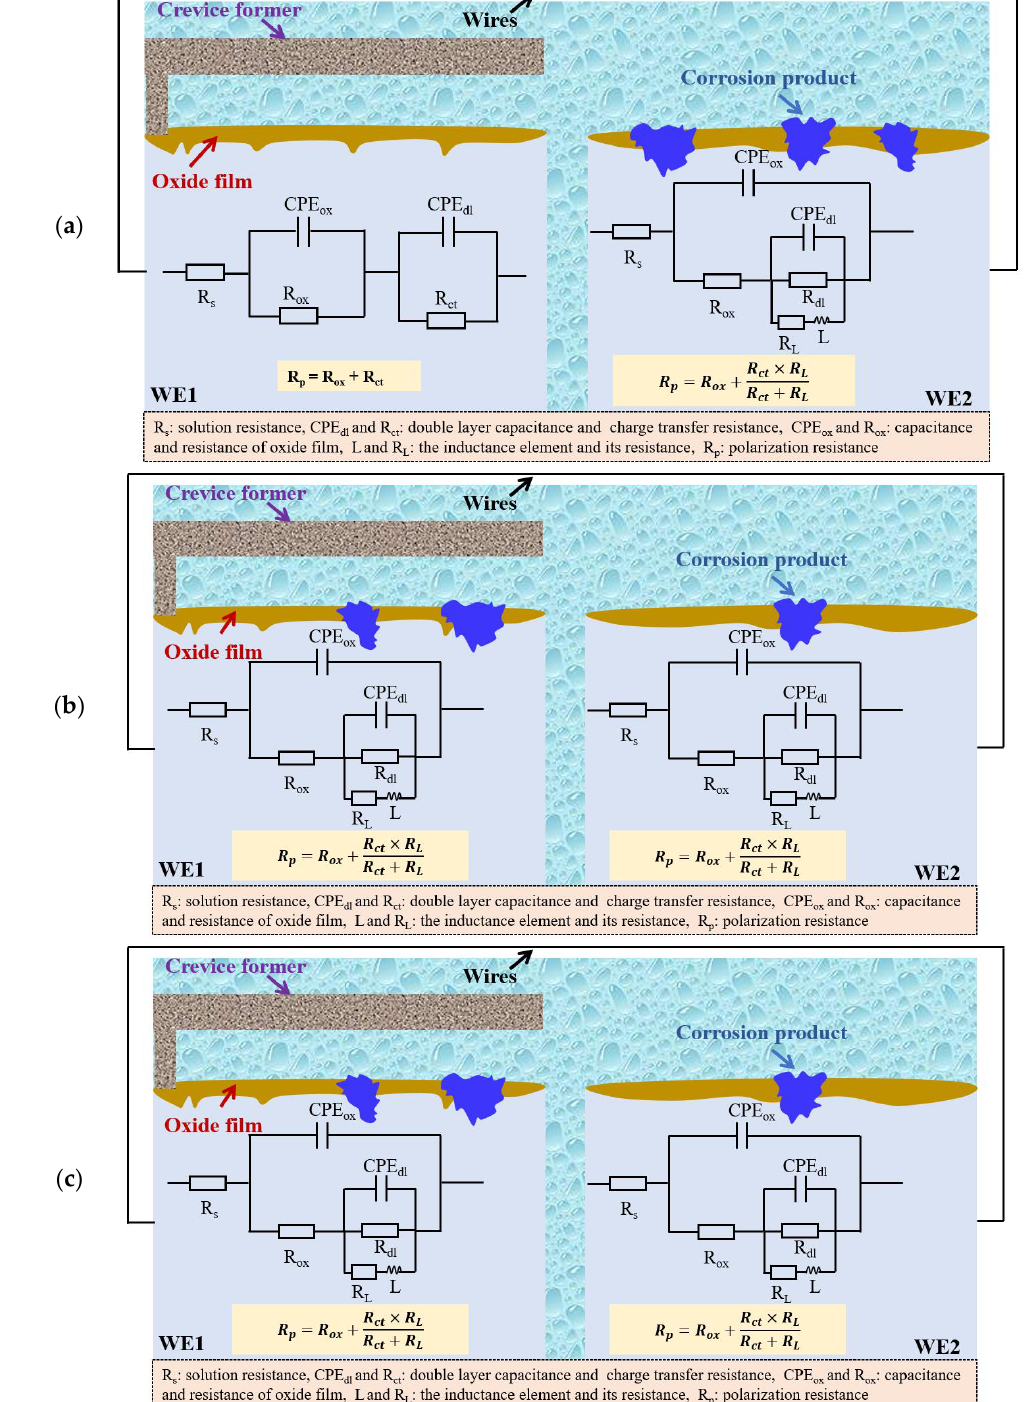
Figure 6. The interfacial structures and equivalent circuits of WE1 and WE2 specimens in solutions with different concentrations of NaNO 3 after corrosion for 24 h. ( a ) 0 wt.% NaNO 3 , ( b ) 0.2 wt.% NaNO 3 , ( c ) 0.5 wt.% NaNO 3 .